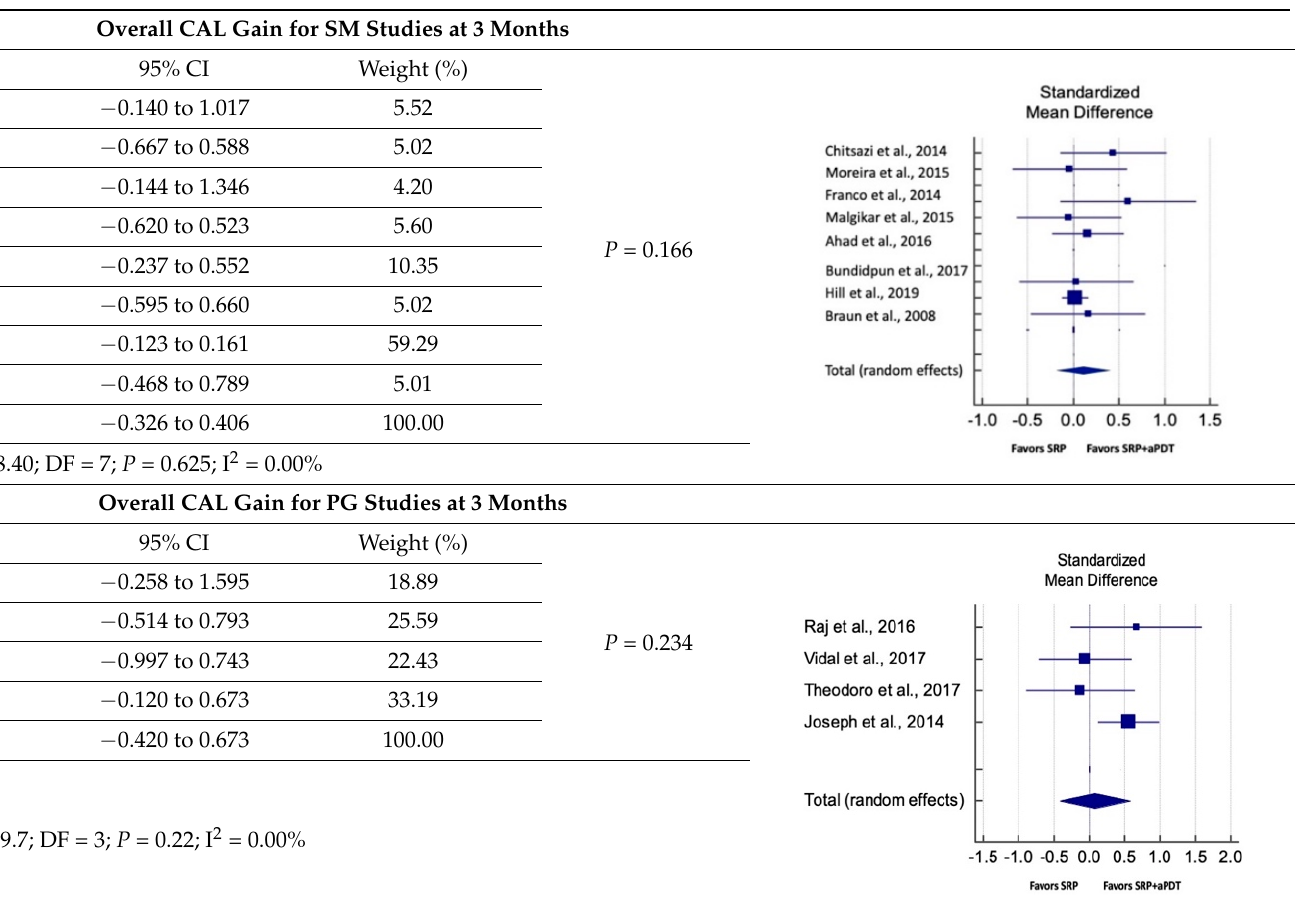
Figure 6. ( a , b ) Funnel plots illustrating the publication bias in overall PPD reduction in SM and PG studies, respectively; ( c , d ) funnel plots illustrating the publication bias in overall CAL gain in SM and PG studies, respectively. Each circle represents a single included study, the y-axis and x-axis represent the standard error of the effect estimate and the results of the study respectively and the graphical plot resembles an inverted funnel with scatter due to sampling variations. 4. Discussion Based on the hypothesis that aPDT monotherapy or as an adjunct to NSPT can en- hance the clinical or microbiological or immunological profile in comparison to conven- tional SRP, or SRP+AB, a critical appraisal of the available scientific evidence was con- ducted. After meticulous scrutiny, 31 studies were included in the present systematic re- view [2,3,5,17,70–96]. Owing to the methodological discrepancies, only 18 out 31 studies were eligible for a meta-analysis [17,71,73–76,80,81,84–86,88–93,96]. This report is the first to evaluate the role of SRP+aPDT compared to SRP alone or SRP+AB in SM and PG studies in AgP as well as in CP patients. The results of this meta-analysis indicated that, in com- parison to SRP alone or SRP+AB, SRP+aPDT failed to show any additional benefit in the management of periodontitis up to six months. A significant heterogeneity was reported, arising from confounders in aPDT protocols. Subsequently, after omitting outlier studies [74,86,90,92,93], sensitivity analysis was able to eliminate heterogeneity completely